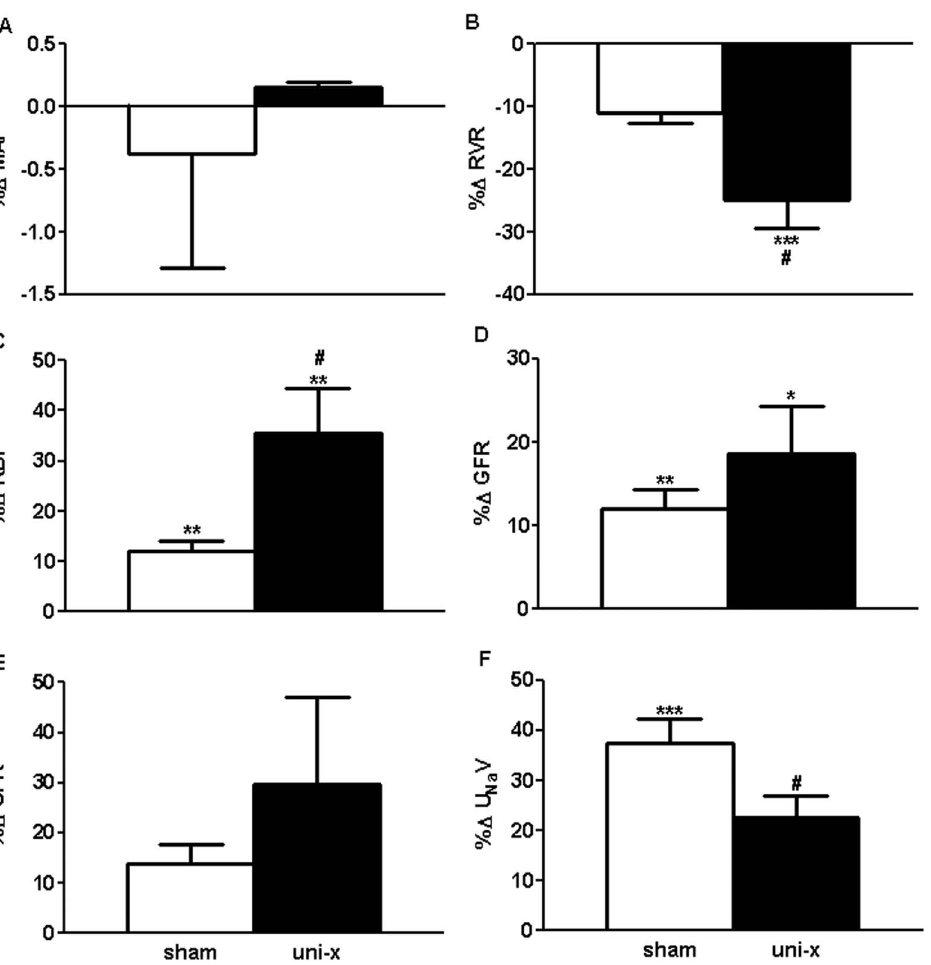
Figure 3. Cardiovascular and renal responses to Angiotensin II infusion in the presence of AT1R blockade via losartan expressed as percentage change (% D ) from losartan infusion period in sham and uni-x female sheep at 5 years of age (n=5/group). MAP, mean arterial pressure; RVR, renal vascular resistance; RBF, renal blood flow; GFR, glomerular filtration rate; UFR, urine flow rate; U Na V, urinary sodium excretion; all values except MAP are corrected for total kidney weight (gkw). Sham: white bars, uni-x: black bars, *P , 0.05, **P , 0.01, ***P , 0.001, from Bonferroni post-hoc test comparing responses of sham or uni-x animals to AngII plus losartan from their losartan infusion period. Values are mean 6